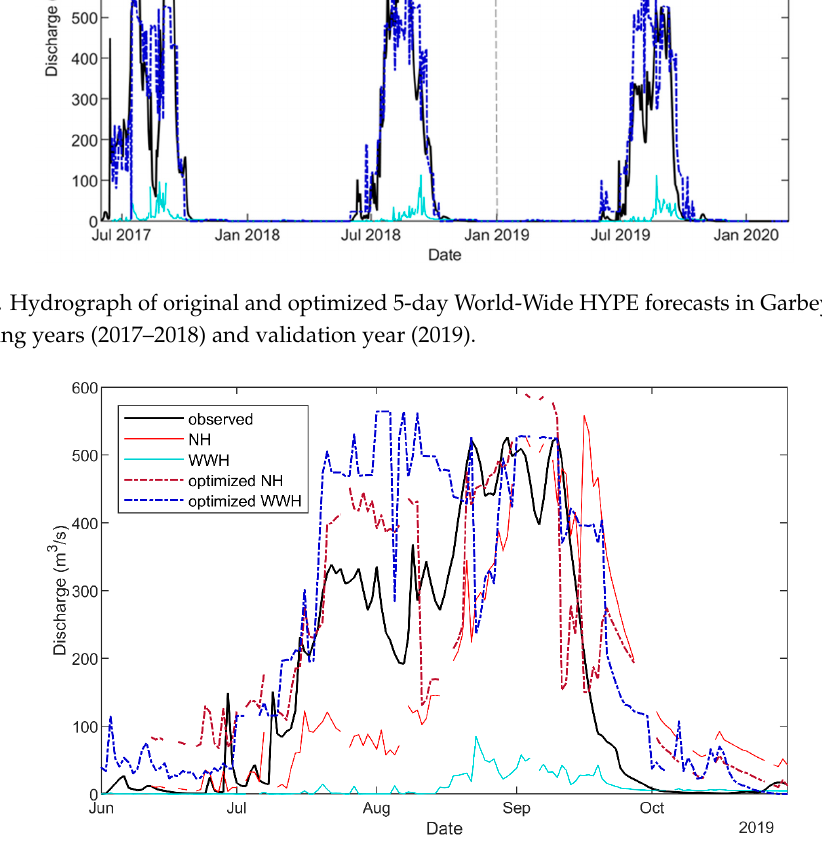
Figure 6. Hydrograph of original and optimized 5-day World-Wide HYPE forecasts in Garbey Kourou for training years (2017–2018) and validation year (2019).